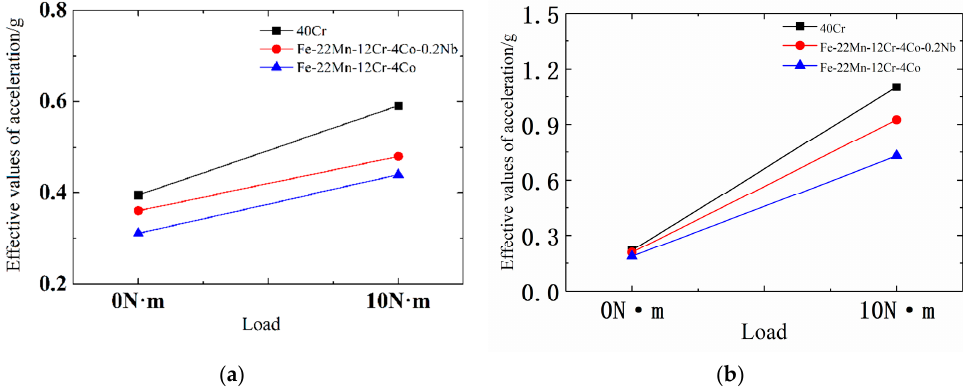
Figure 22. Comparison of the results of different loading: ( a ) results of measuring point 1 at the speed of 700 rpm; ( b ) results of measuring point 3 at the speed of 900 rpm.